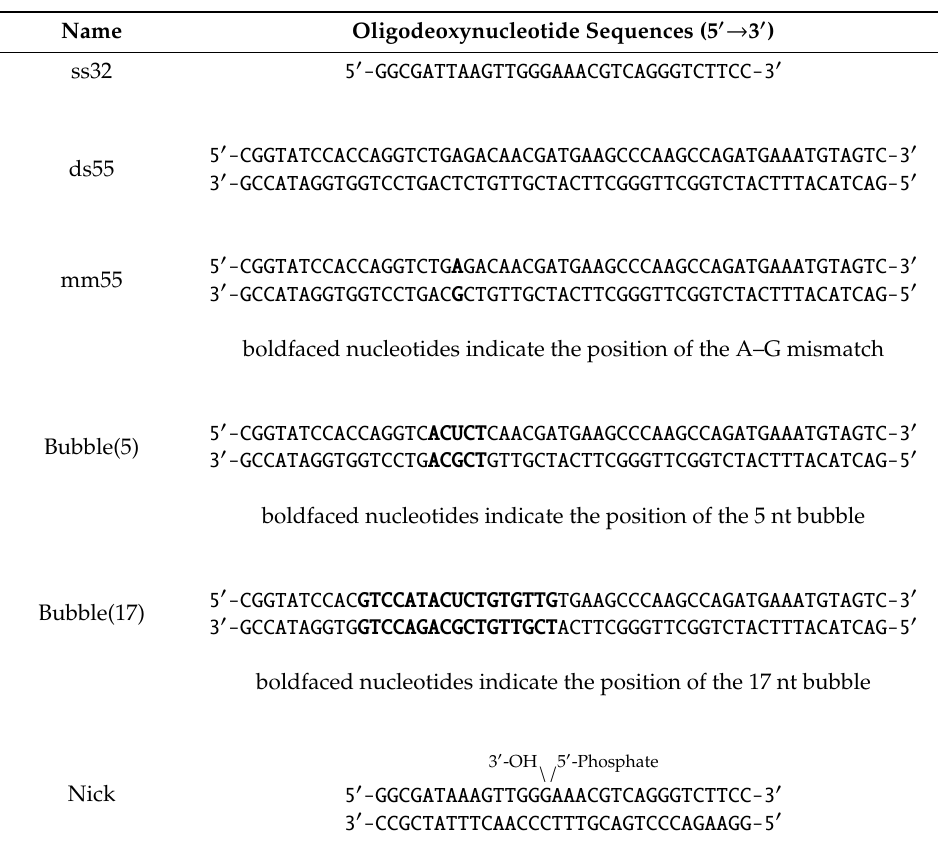
Table 1. Structures and names of the DNA